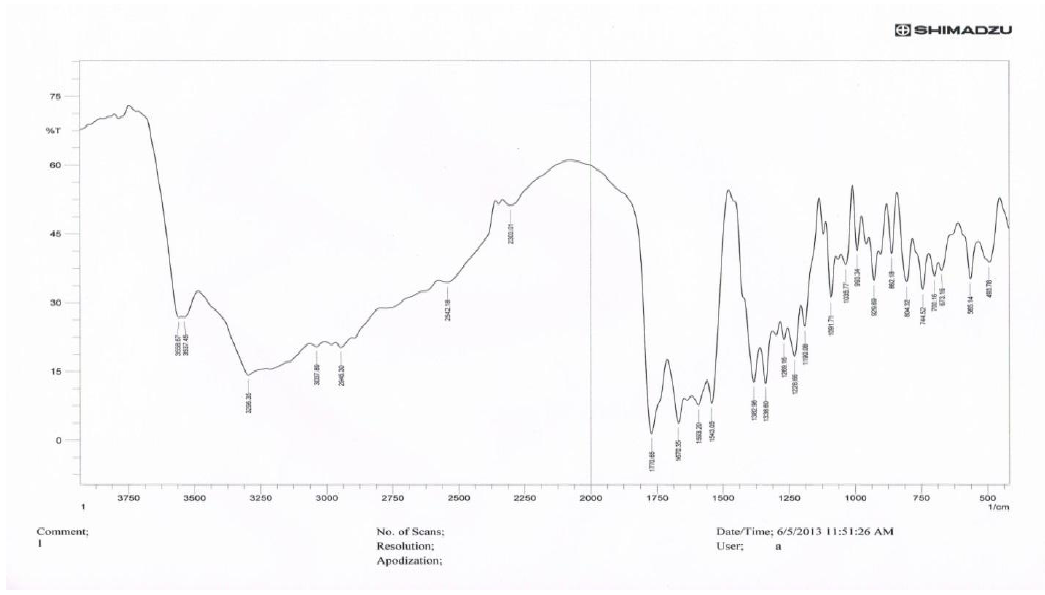
Figure 2: FT-IR spectrum of pure cefixime